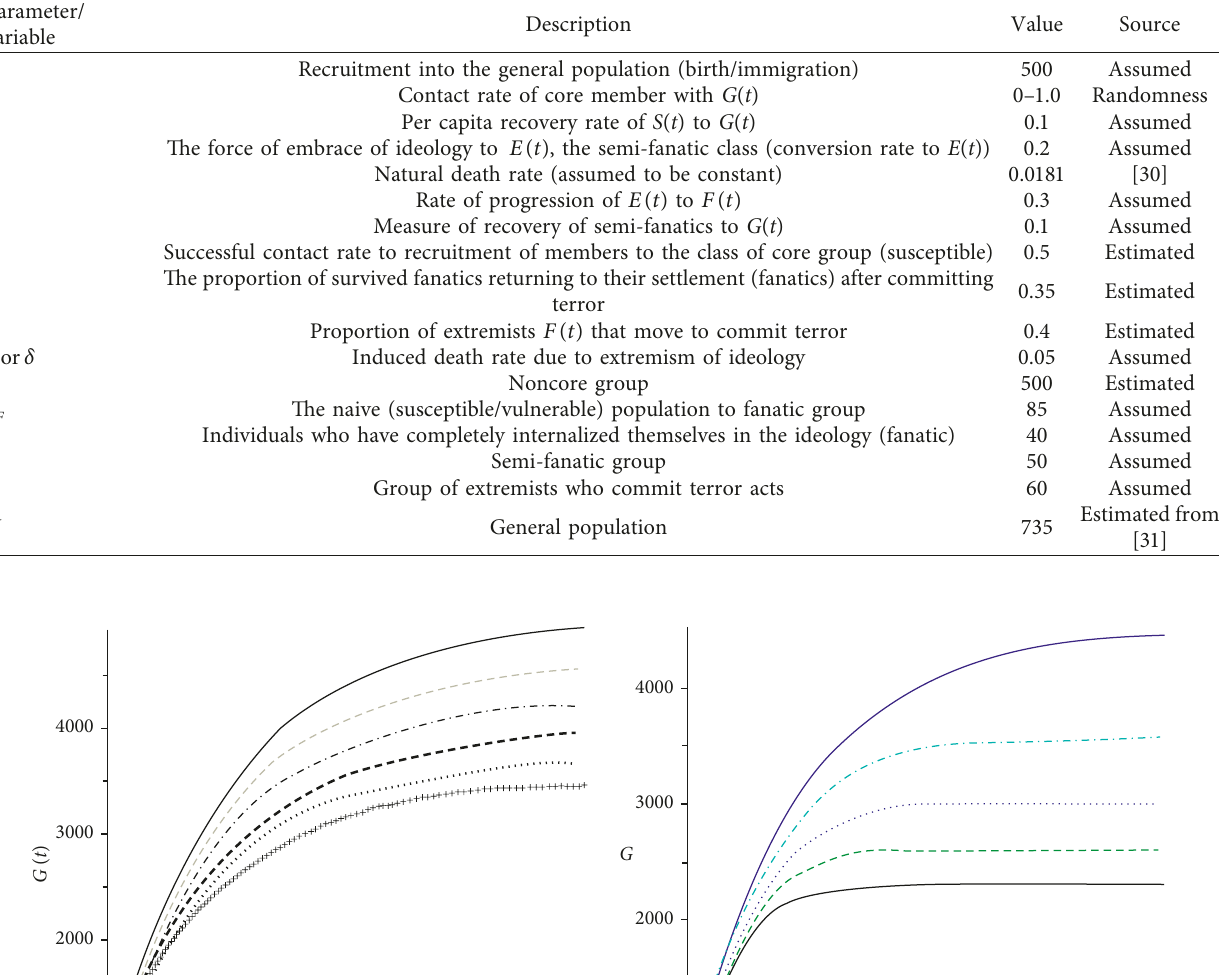
Table 1: Description of parameters and variables of the model and value used for numerical